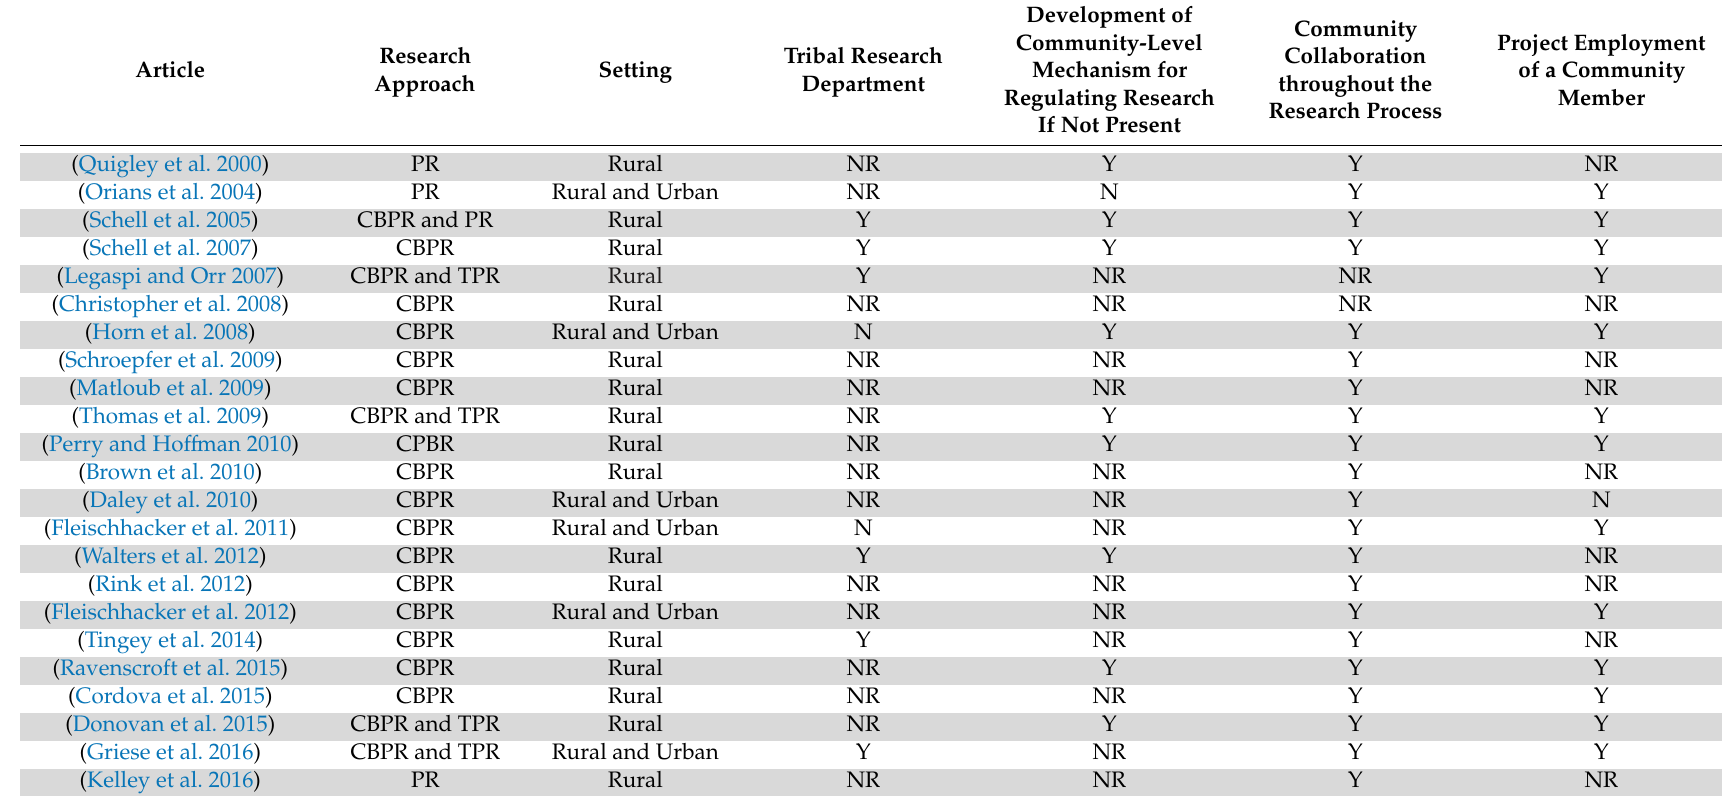
Table 2. Community-level protection measures across scoping review articles (N =